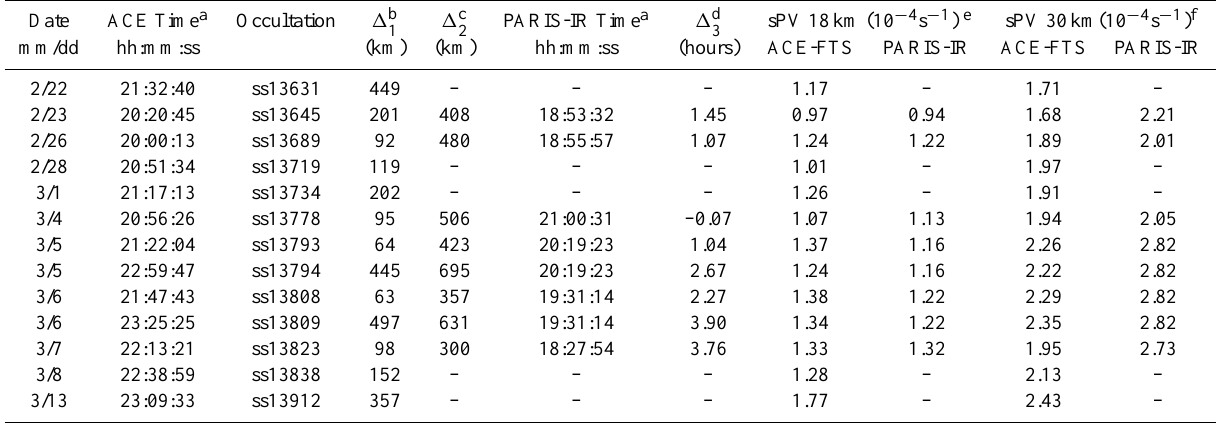
Table 6. The spatial and temporal differences between PARIS-IR and ACE-FTS observations of O 3 , HCl, ClONO 2 , HF, HNO 3 , and NO 2 during the 2006 Canadian Arctic ACE Validation